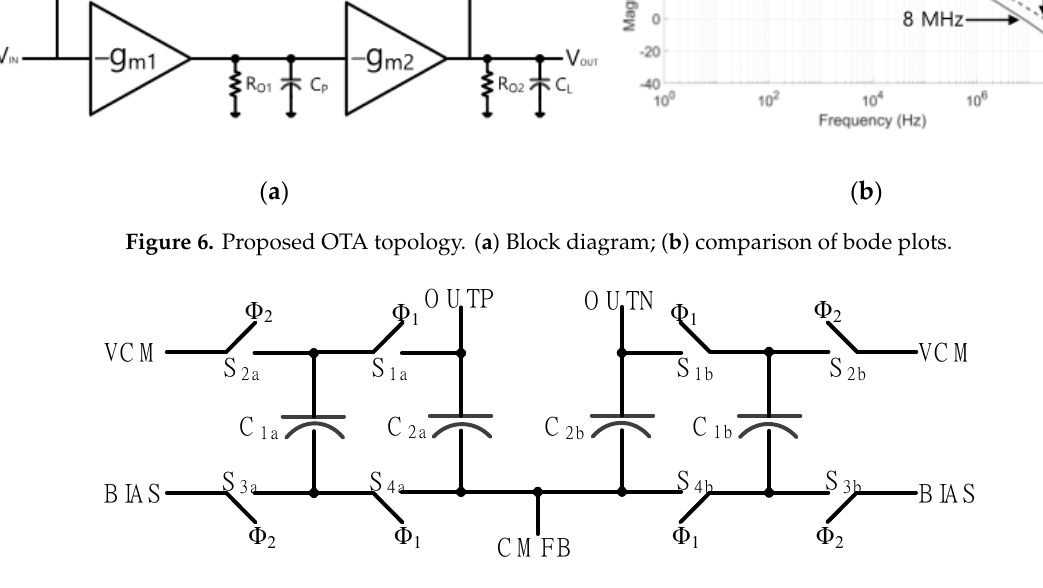
Figure 7. A schematic of the switched-capacitor common-mode feedback (CMFB) circuit.